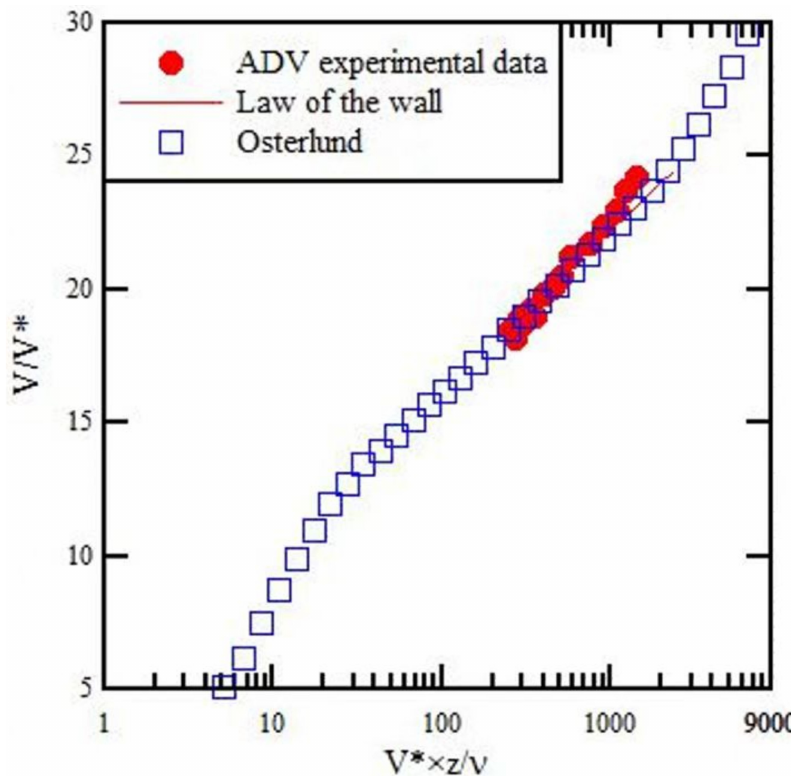
Figure 2. Dimensionless velocity distribution in the steady flow. Time-averaged velocity V x / V *. Comparison between ADV data, law of the wall, and Osterlund [39] (redrawn from